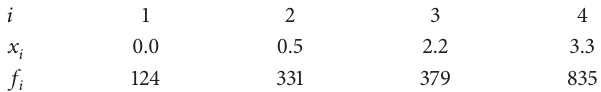
Table 4: The monotone dataset given in